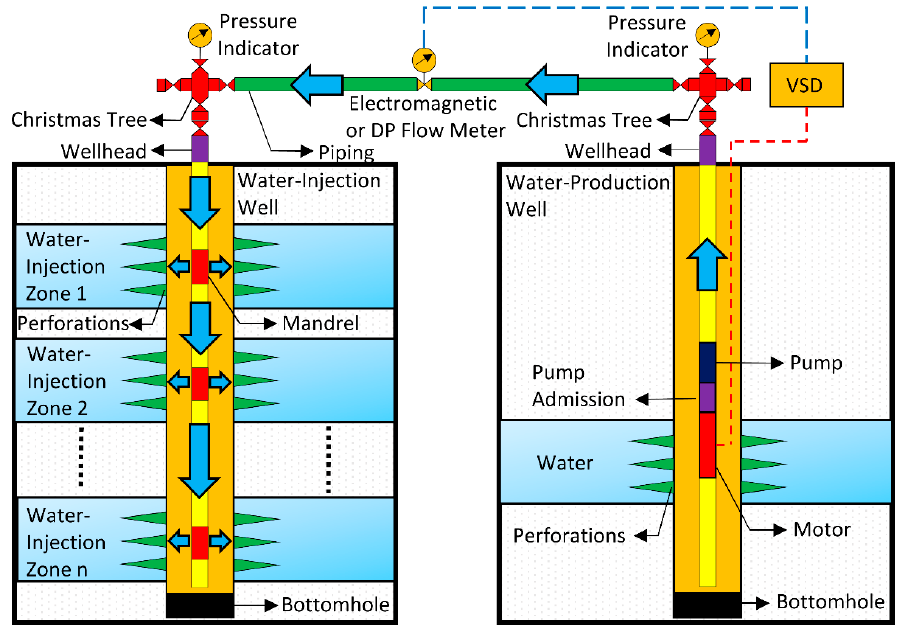
Figure 2. A typical water-injection system composed of a multiple-zone water-injection well and a water-production well. The total flow of water is measured and controlled on the surface. The injected flow rates are controlled by mechanical downhole flow regulators and there is no real-time, in-line flow rates measurement in the injection zones. VSD refers to a variable speed drive. DP refers to differential pressure.